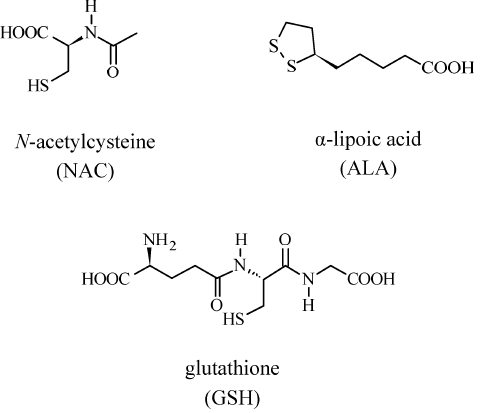
Figure 3. Antioxidants such as N -acetylcysteine (NAC), α -lipoic acid (ALA), and glutathione (GSH).